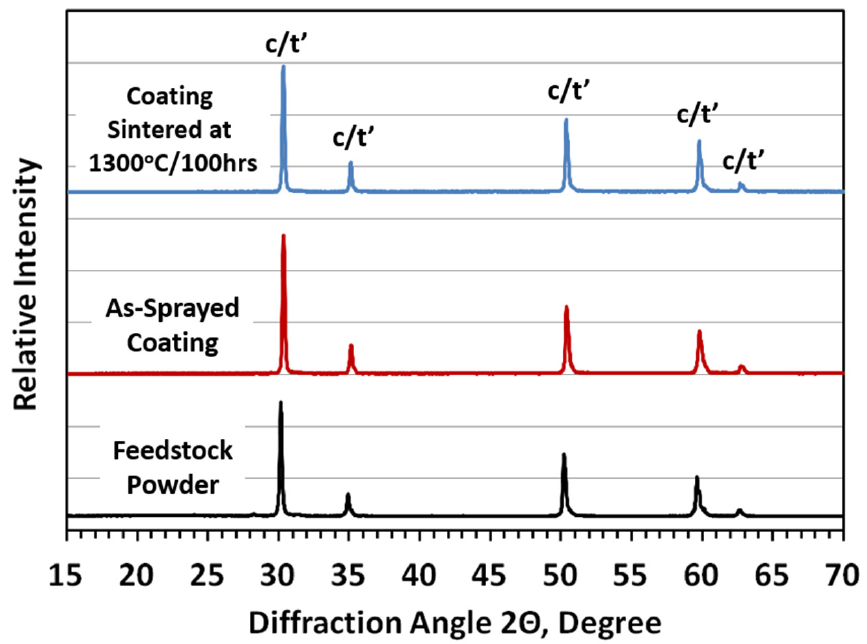
Figure 6. SEM images of the cross-sections of two-phase composite TBCs after isothermal exposure at 1300 ◦ C/100 h: ( a ) fracture morphology of the as-sprayed topcoat; ( b ) fracture morphology of the thermally exposed topcoat; ( c ) microstructure of the as-sprayed topcoat; ( d ) microstructure of the thermally exposed topcoat.